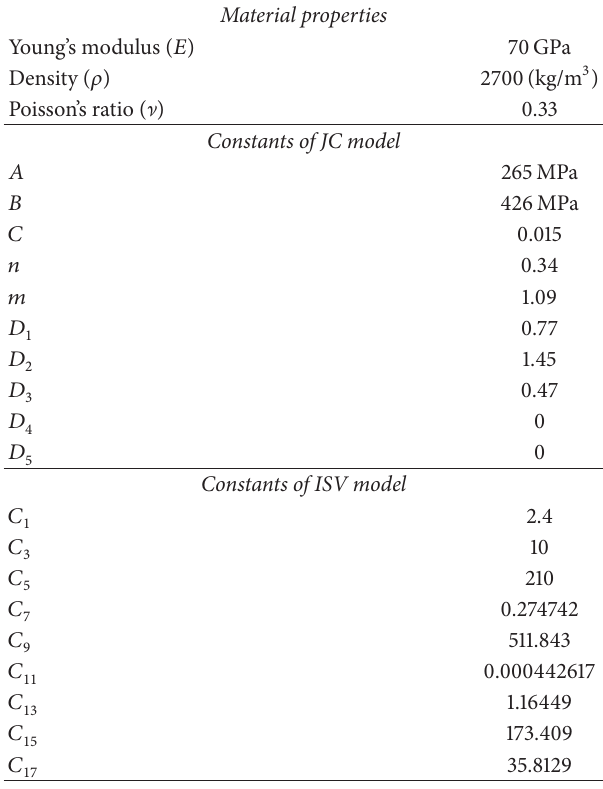
saved as experimental data for DMGfit, as plotted in Figure 1. and at initial temperatures 298.15 ∘ F and 542 ∘ F, respectively.